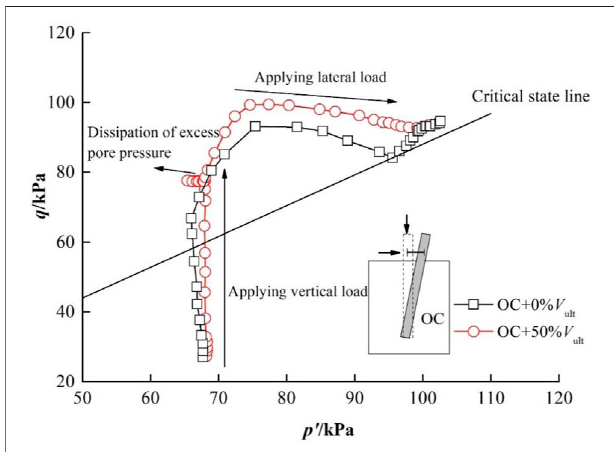
FIGURE 11 | Stress path of the selected soil element in the OC